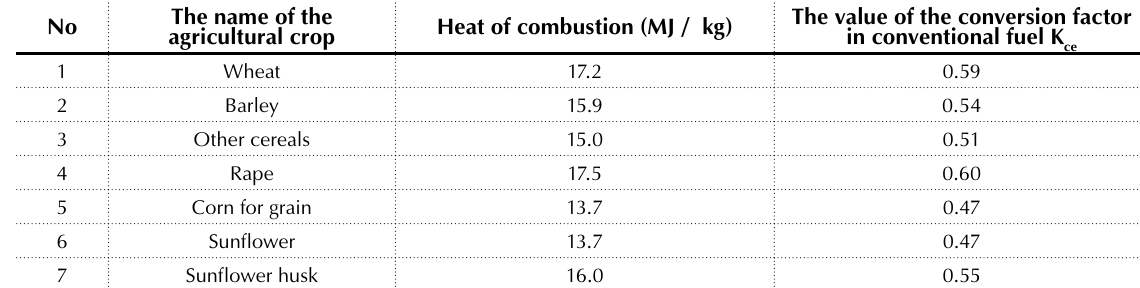
Source: Calculated by the author on the basis of Institute of local development (2013). Heat of combustion (MJ / kg)